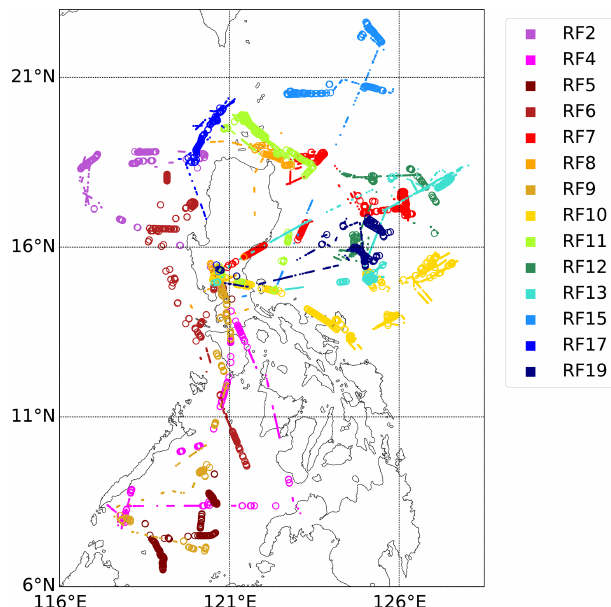
Figure 1. Flight tracks for 14 P-3 research flights (RFs) with Terra MODIS overpass coordination over the CAMP 2 Ex region. Dots in- dicate remote sensing legs with valid RSP retrievals; hollow circles indicate in situ legs with a FCDP number concentration > 10cm − 3